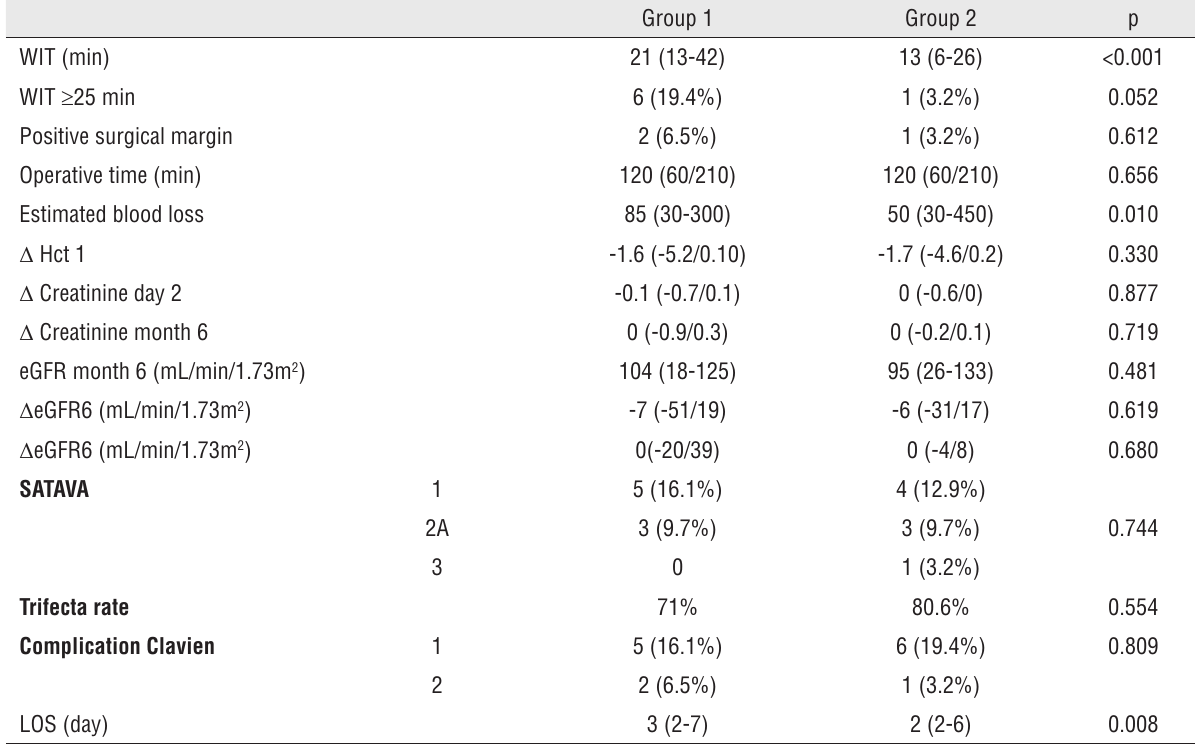
Table 2 - Comparison of perioperative and postoperative outcomes between groups.